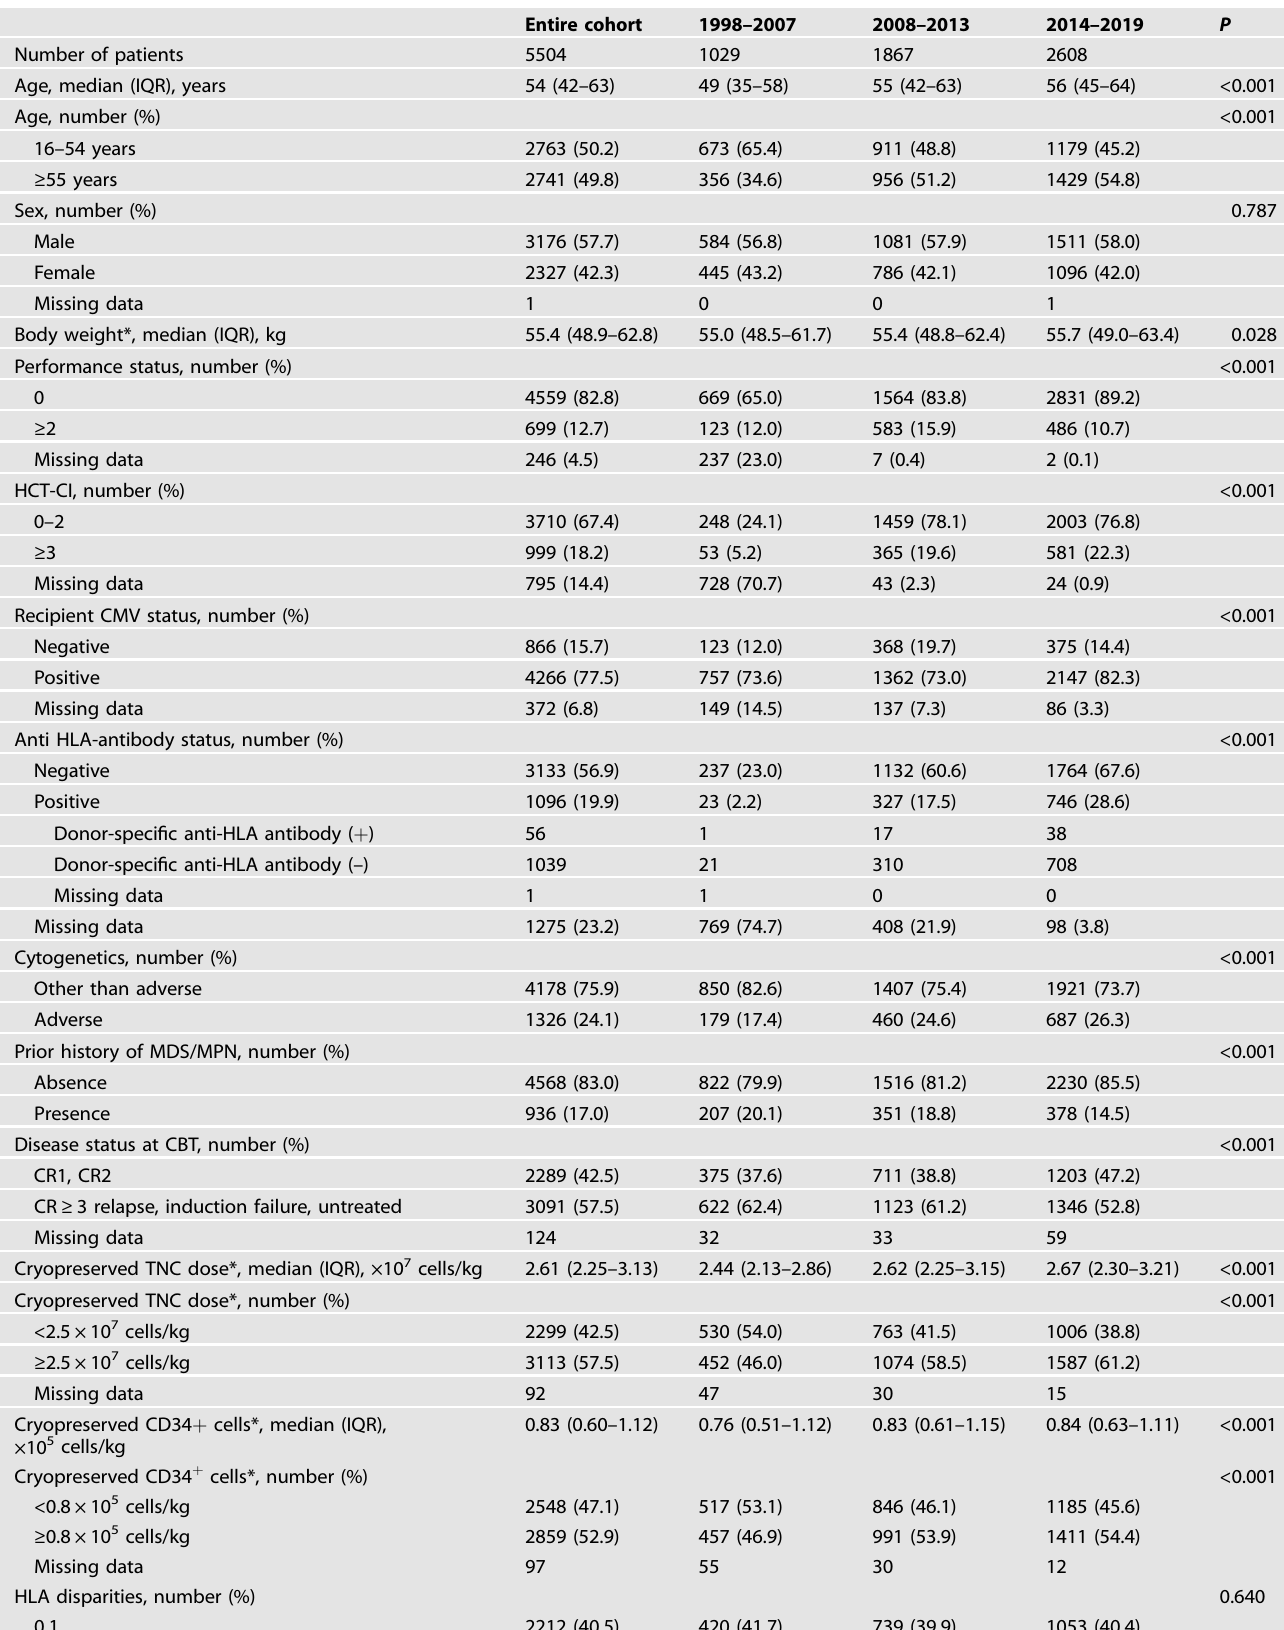
Table 1. Patient and transplant